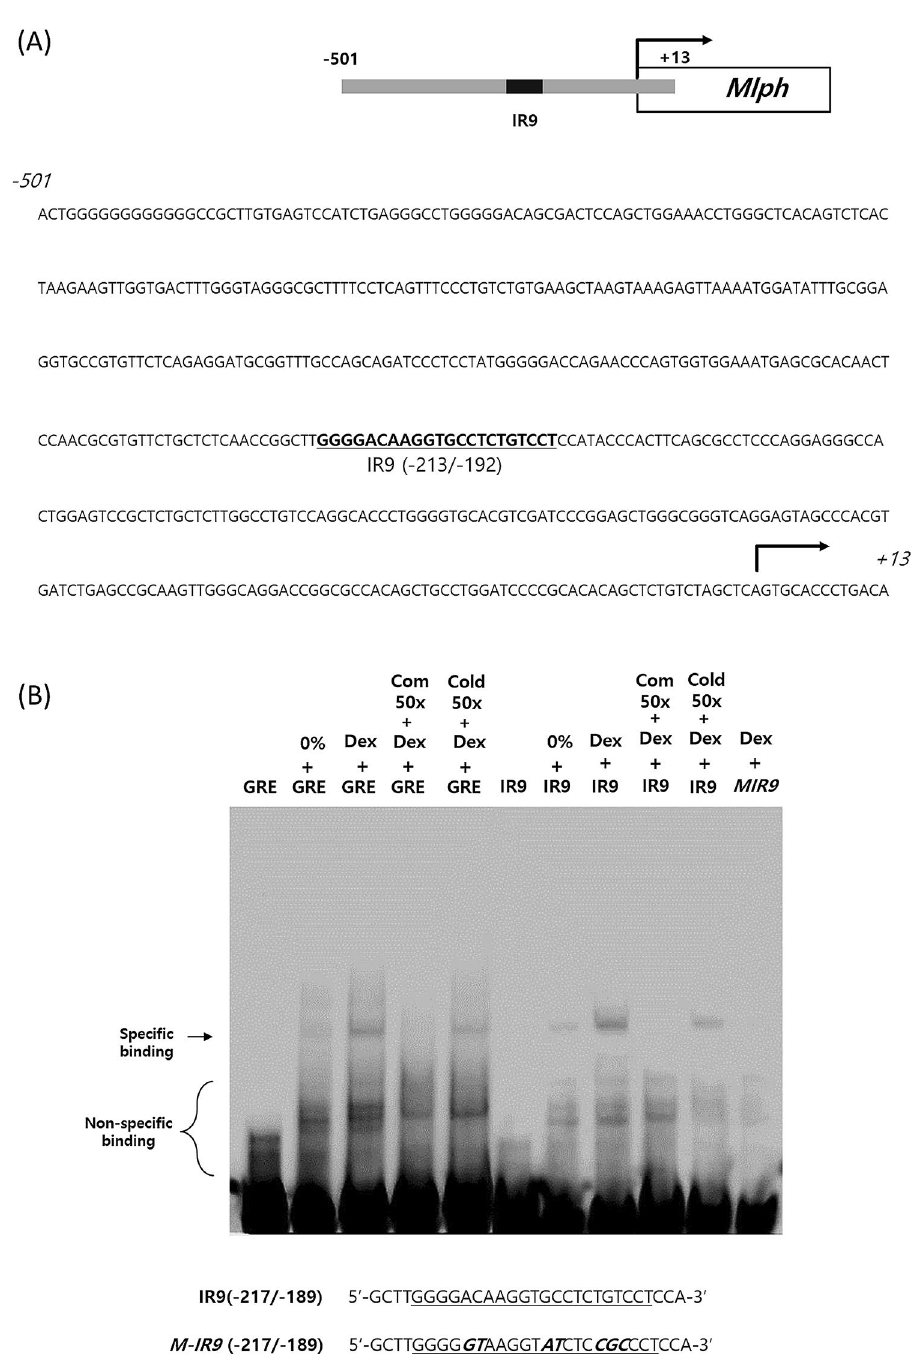
Figure 6. Dex increases GR binding to IR9 of the Mlph promoter. ( A ) DNA sequence of the Mlph promoter. Sequence shows the Mlph promoter from TSS to -501. IR9 represents one of the high ranked GR binding sites predicted by NUBIscan. ( B ) Effect of Dex induced-alteration of GR activity on binding affinity to IR9 of the Mlph promoter. Melan-a melanocytes were cultured in serum-free medium with or without 1 µM Dex. Cell nuclear extracts were reacted with biotin-labelled GRE, IR9 or mutated IR9 (M-IR9); a 50-fold excess of each unlabeled probe was used as a competitor. Binding reactions proceeded in ice for 1 h and binding of GR and the probe was confirmed by electrophoretic band shift. All data in this figure represent the mean ± SD of three independent experiments. Data were analyzed by Student’s t-test. ** P < 0.01, *** P < 0.001. The band intensity was quantified using NIH ImageJ software 1.45 s and normalized. Quantification of band-shift was provided in Supplemental